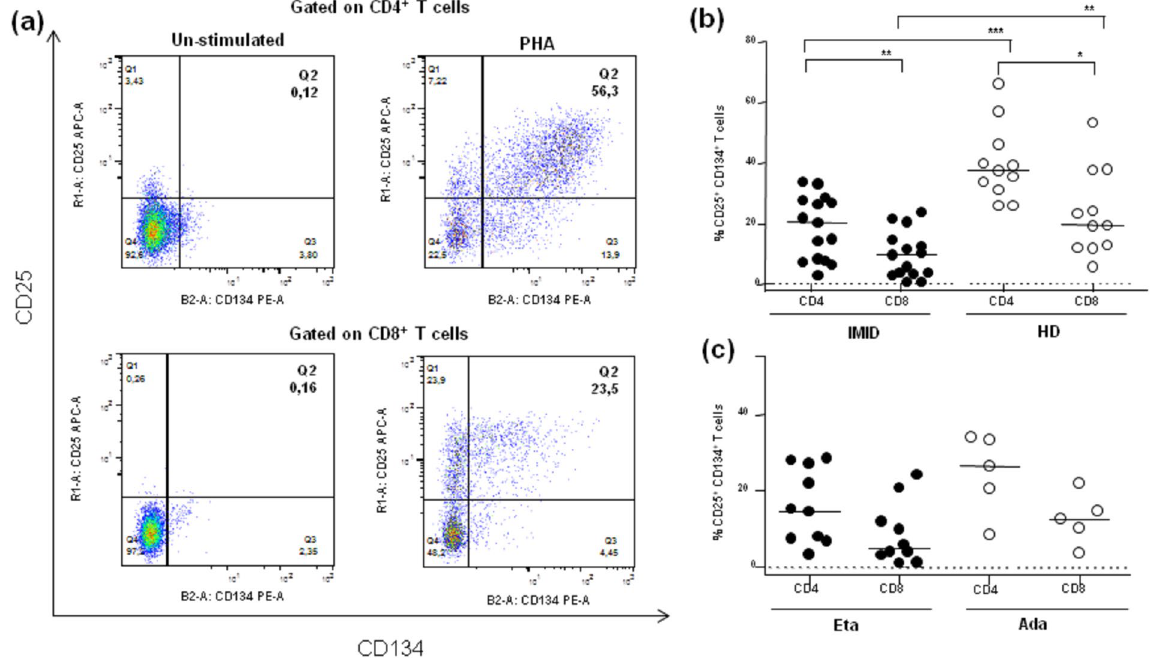
Figure 2. Characterization of the ex vivo CD25 + CD134 + T cell assay. ( a ) Representative dot plots from healthy donors (HD) showing the staining for CD25 + CD134 + T cells in whole blood cultures in response to either control ( left ) or phytohemagglutinin (PHA) at 5 μ g (right ). The percentages of CD25 + CD134 + T cells are shown in upper right quadrants. (b) Frequencies of CD25 + CD134 + T cells in response to PHA in 15 IMID patients after 8 years of treatment with TNF antagonists and in 11 HD are shown. Statistical analysis was performed using the Mann-Whitney test to compare IMID and HD subjects and significant p -values are indicated. (c) Frequencies of CD25 + CD134 + T cells were assessed according to the type of biological agent. Statistical analysis was performed using the Mann-Whitney test to compare subjects treated with Eta and Ada. Horizontal bars represent the median values and horizontal dashed lines indicate the cut-off of positive response corresponding to 0.47% (mean 0.098, SD 0.12) for CD4 + T cells, and 0.41% (mean 0.11, SD 0.09) for CD8 + T cells. The cut-off for a positive response was calculated as the mean response (%) ± 3SD of negative